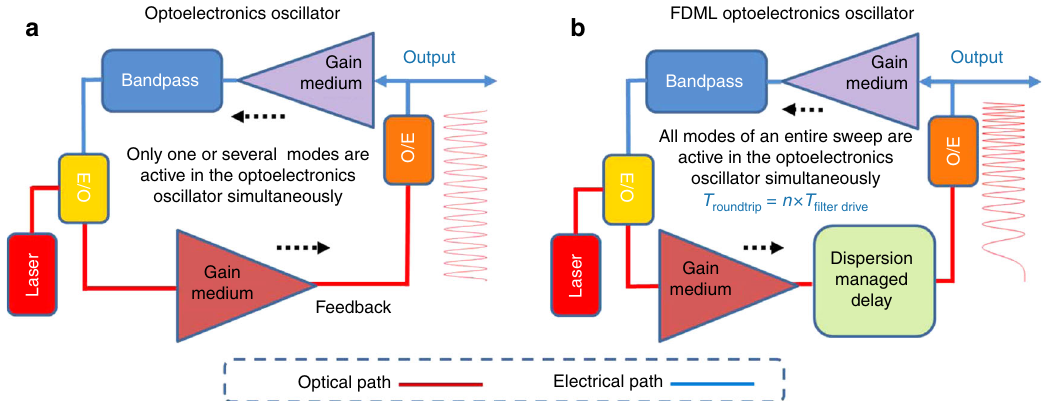
Fig. 1 Schematic to show the operations of a conventional OEO and an OEO based on FDML. a A conventional single-frequency OEO, only one mode is active in the cavity. b An OEO based on FDML for generation of a microwave signal with fast frequency tuning, all modes are active in the cavity. E/O electrical to optical conversion; O/E optical to electrical